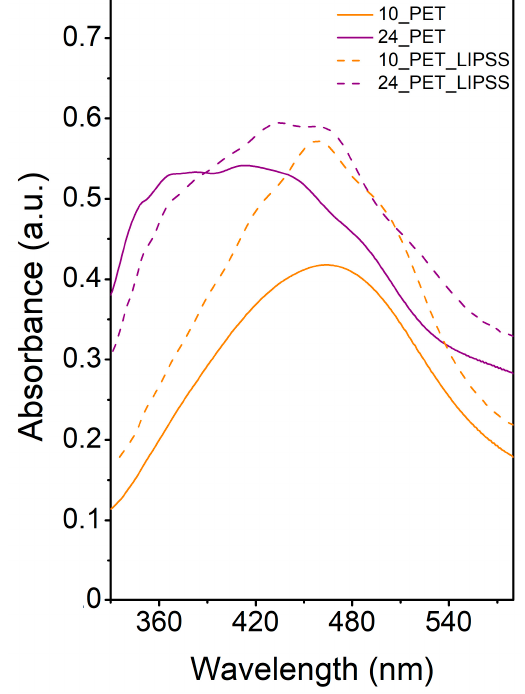
Figure 4. UV-Vis absorption spectra of AgNPs immobilized with the fluence of 10 mJ cm − 2 on pristine PET (10_PET) and PET with LIPSS structure (10_PET_LIPSS) and with the fluence of 24 mJ cm − 2 on pristine PET (24_PET) and PET with LIPSS structure (24_PET_LIPSS).